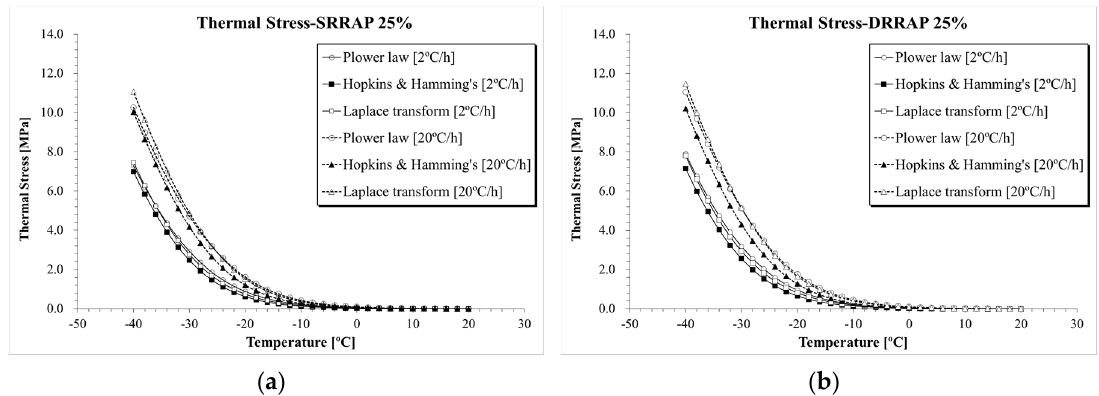
Figure 10. σ ( T ) computation results (Control mixture).